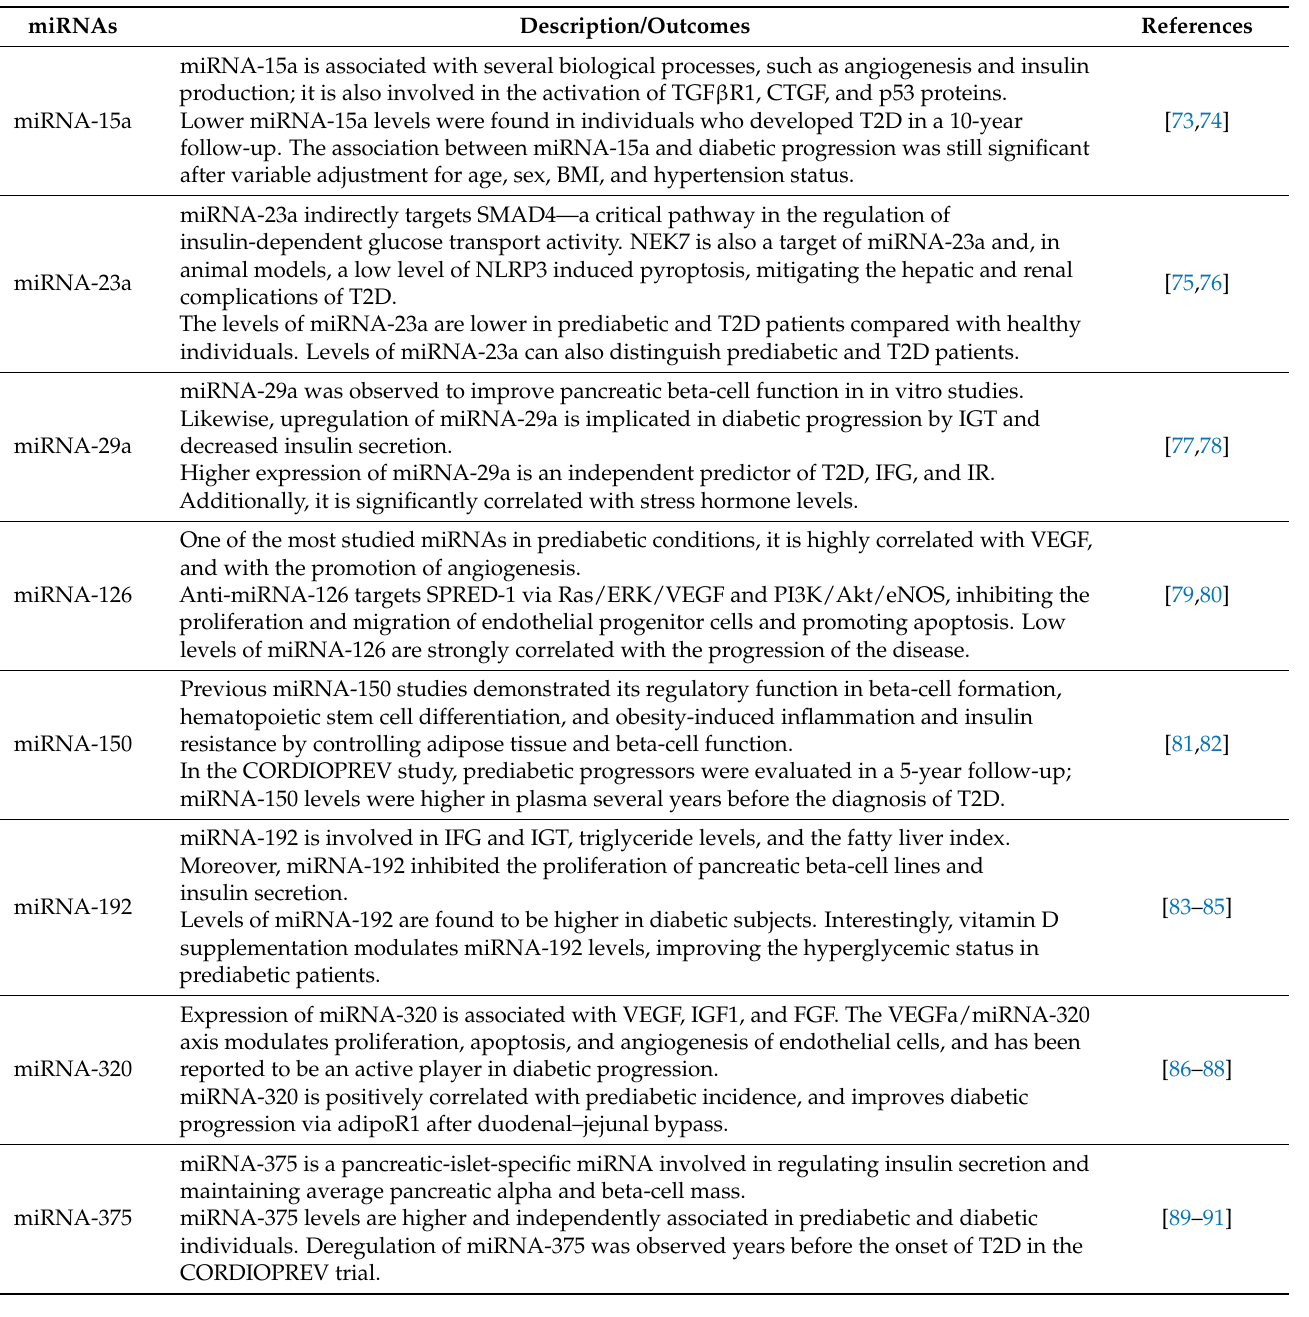
Table 2. A brief description and outcomes of miRNAs expression associated with prediabetes, impaired glucose tolerance, and impaired fasting